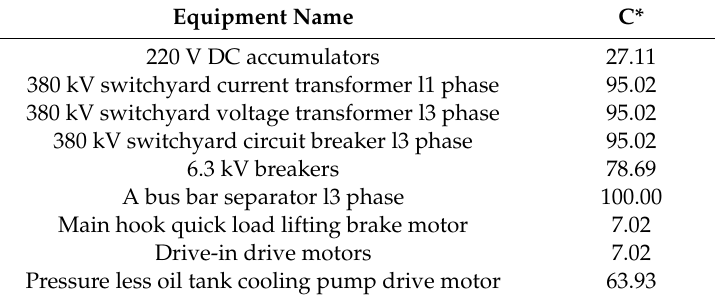
Table 7. Risk values of some